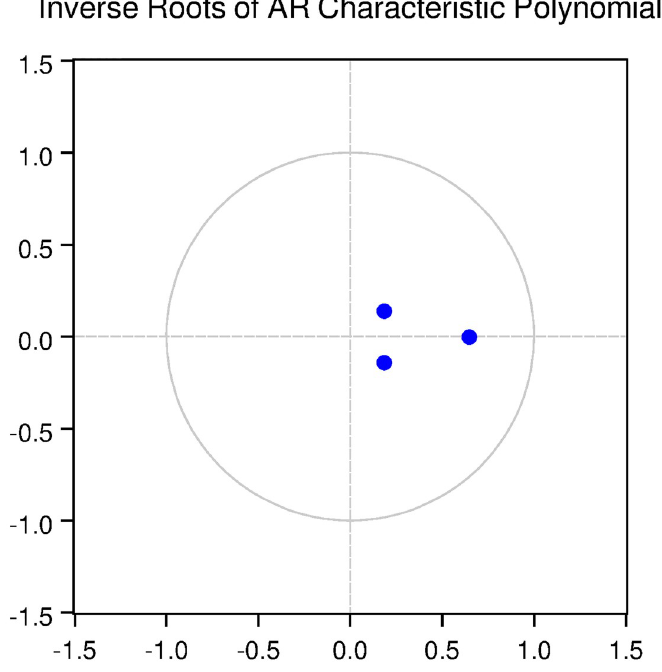
Fig 7. Inverse roots of AR characteristic polynomial for Korean data when P = 1 (proposed model).